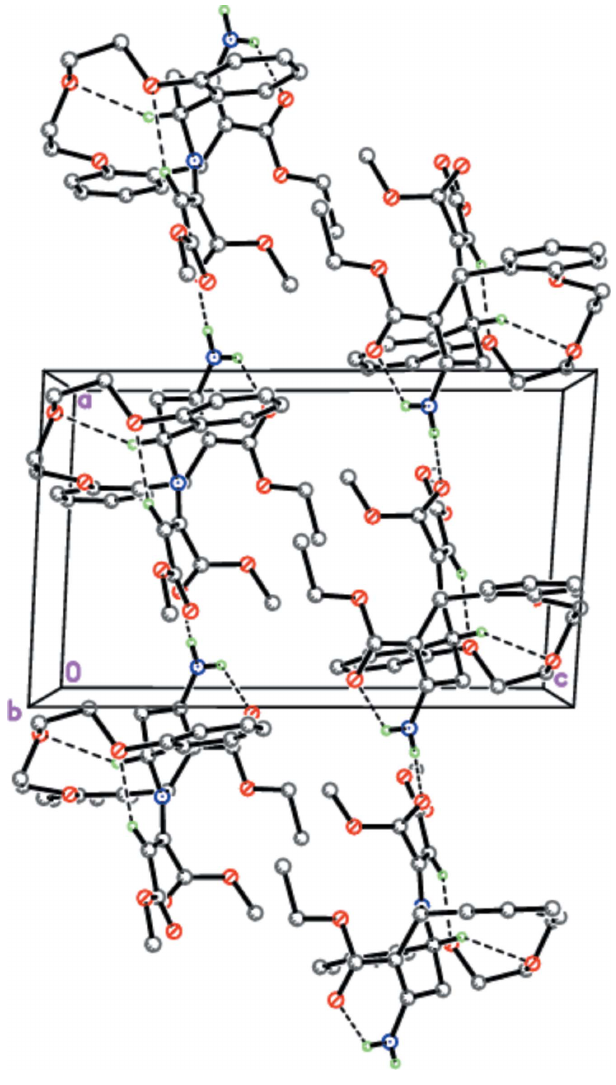
Figure 3 The hydrogen-bonded chains of 4 along the a axis. Dashed lines indicate the intramolecular N—H (cid:3)(cid:3)(cid:3) O and C—H (cid:3)(cid:3)(cid:3) O and the intermolecular N— H (cid:3)(cid:3)(cid:3) O hydrogen bonds.